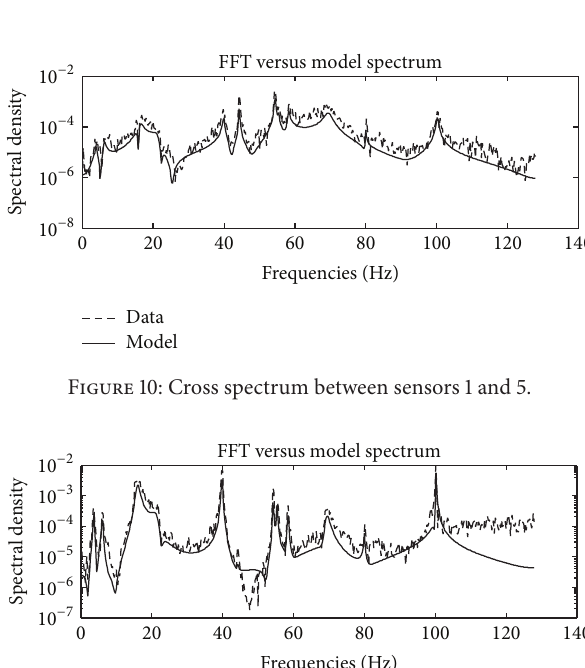
Figure 9: Autospectrum sensor 5.